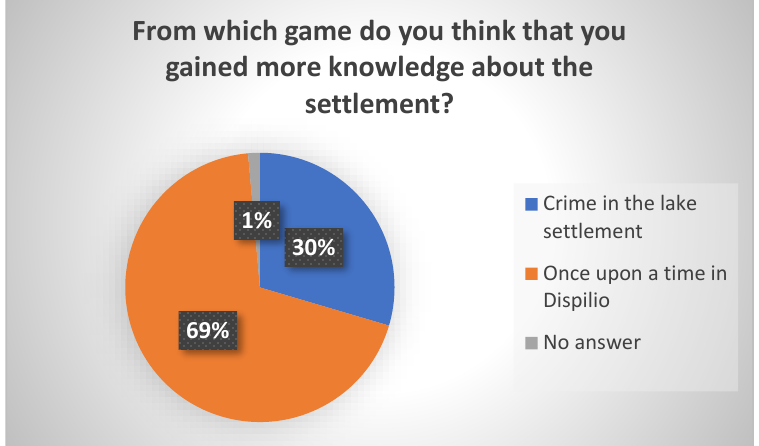
Figure 21. Students think that they learned more from the informative game “ Once upon a time in Dispilio .”